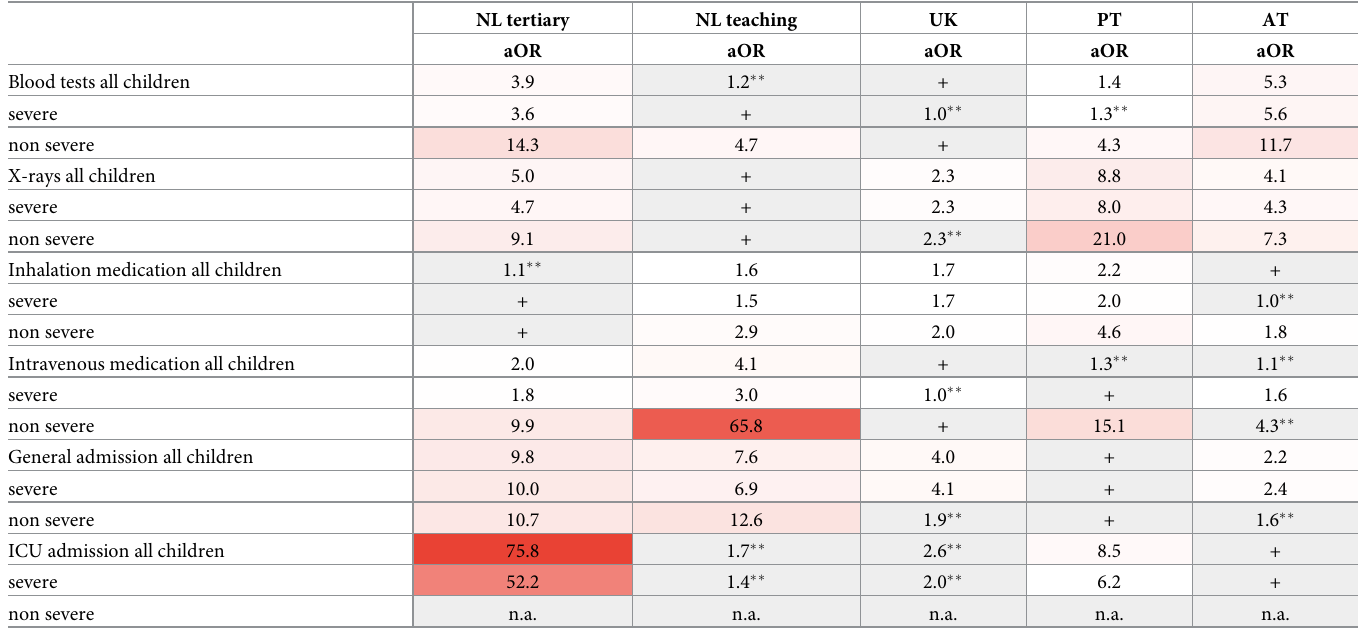
Table 3. Heatmap for patients with different severity with odds ratios of resource use, corrected for patient characteristics #